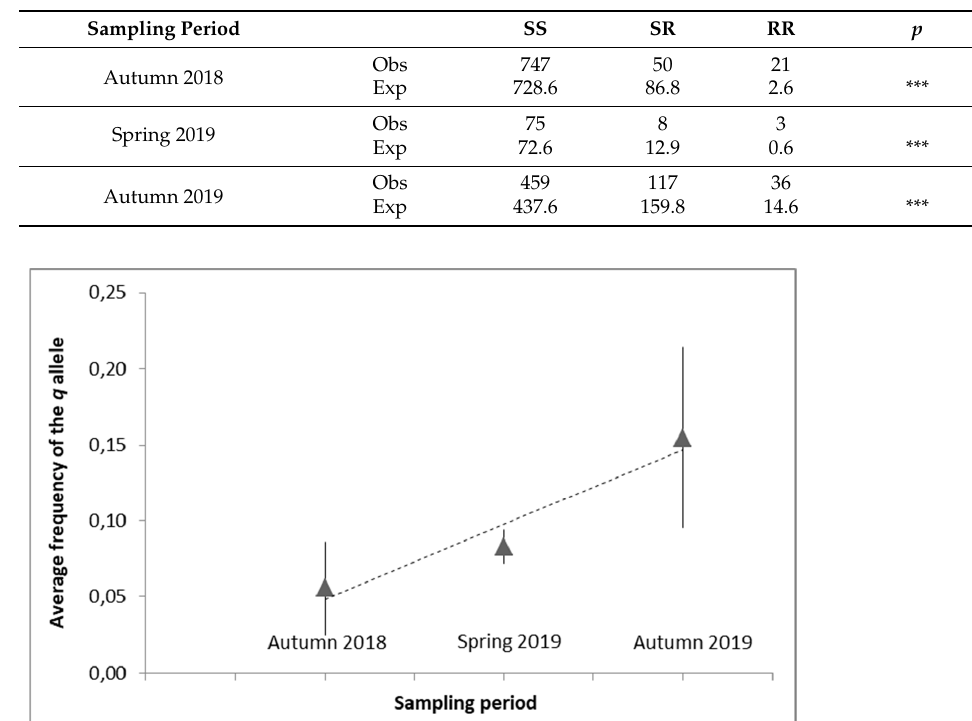
Figure 2. Observed frequency of the resistance allele ( q ) over time (average q across pooled samples). The error bars indicate the 95% confidence intervals. The analysis of the mean frequency of q in the five colonies that were alive at the end of the study revealed a tendency to increase in parallel with the levels of tau-fluvalinate